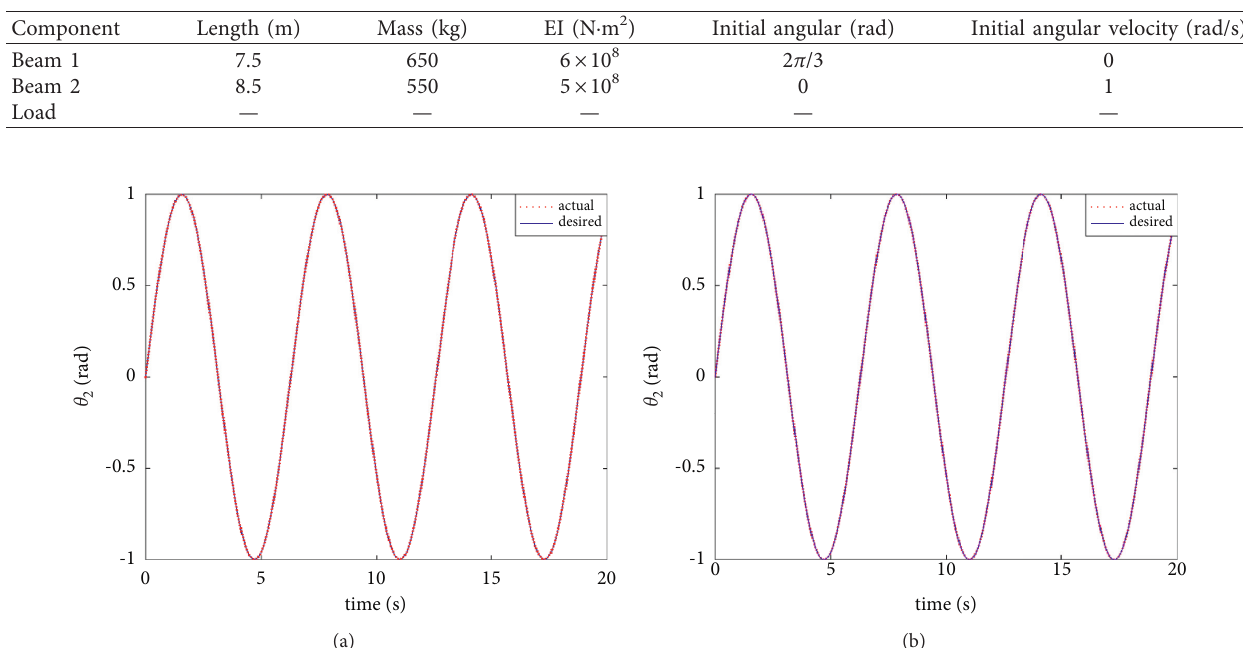
Figure 4: The tracking of θ under the action of (a) backstepping control and (b) NN-based backstepping control. 2